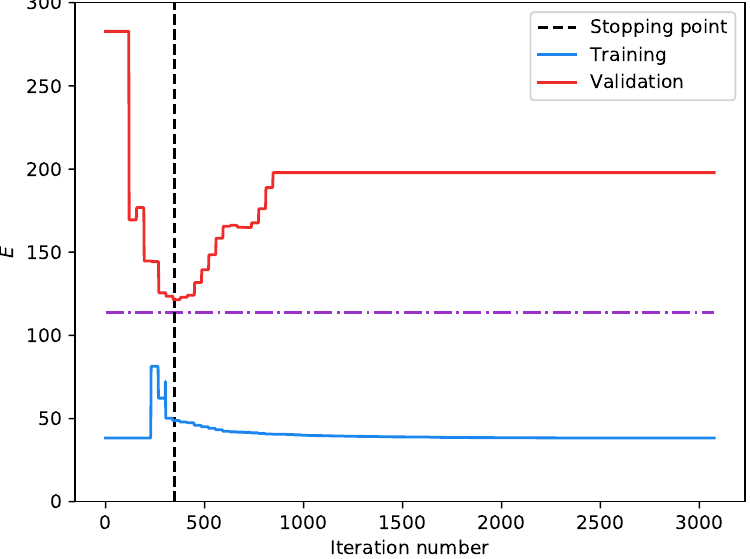
Figure 3 . The values of the training and validation error functions, E tr and E val respectively, as a function of the number of iterations of the minimisation algorithm for a representative data replica. The optimal stopping point, as determined by the cross-validation algorithm, is indicated by the dashed vertical line. The horizontal dot-dashed line indicates the value E=N dat = 2, see